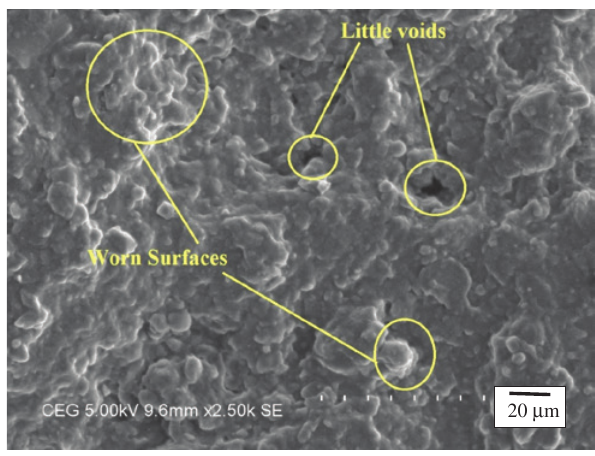
Figure 14: GFRP with CNTs 3% after wear.